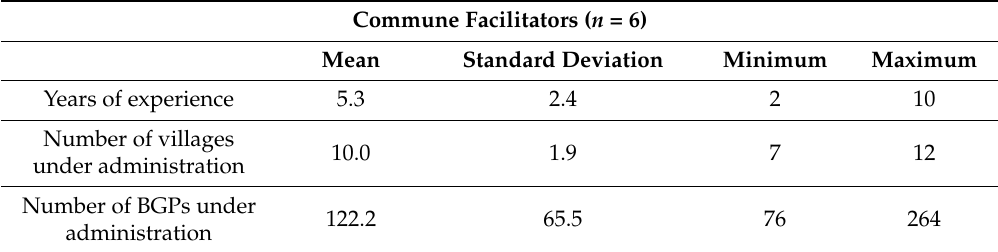
Table 1. Data of the commune facilitators.